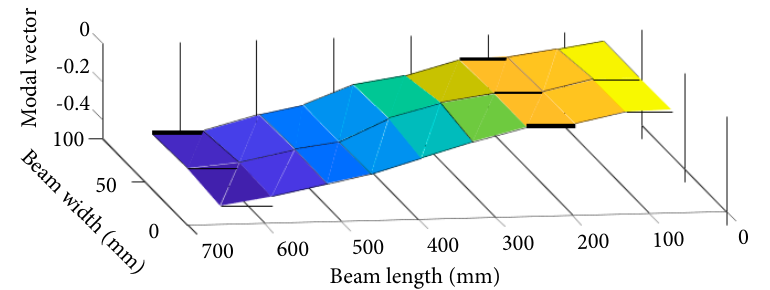
Figure 7. First mode shape experimentally measured.